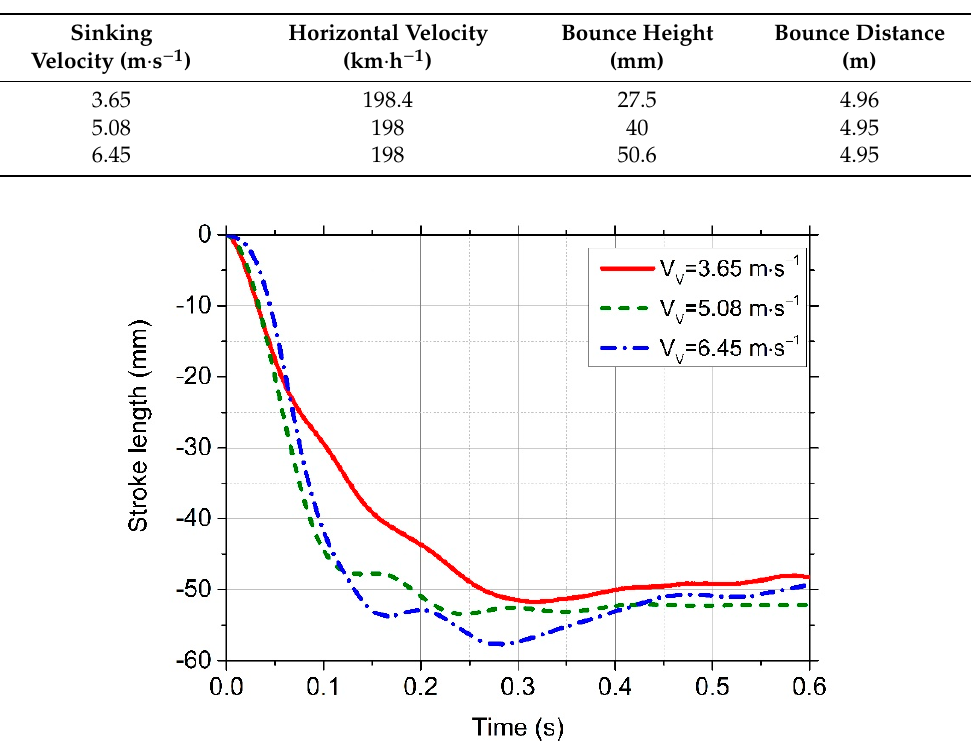
Figure 16. Changes of stroke length of arresting hook at different sinking velocity.